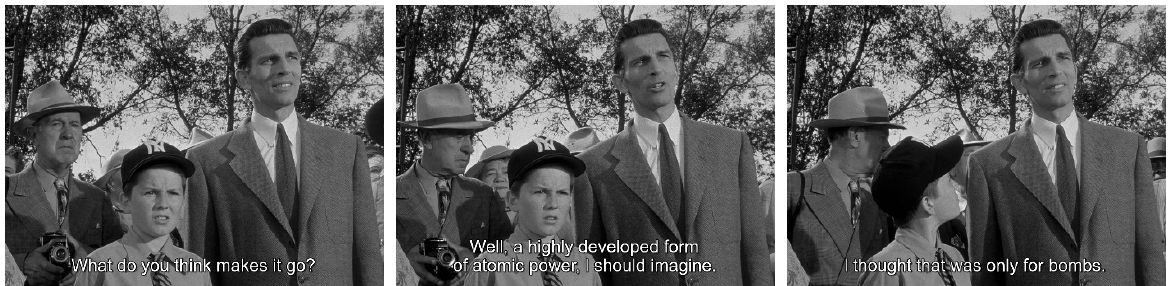
Figure 2. Bobby Benson’s ‘bombs’ comment. The Day the Earth Stood Still © 20th Century Fox. All Rights Reserved.